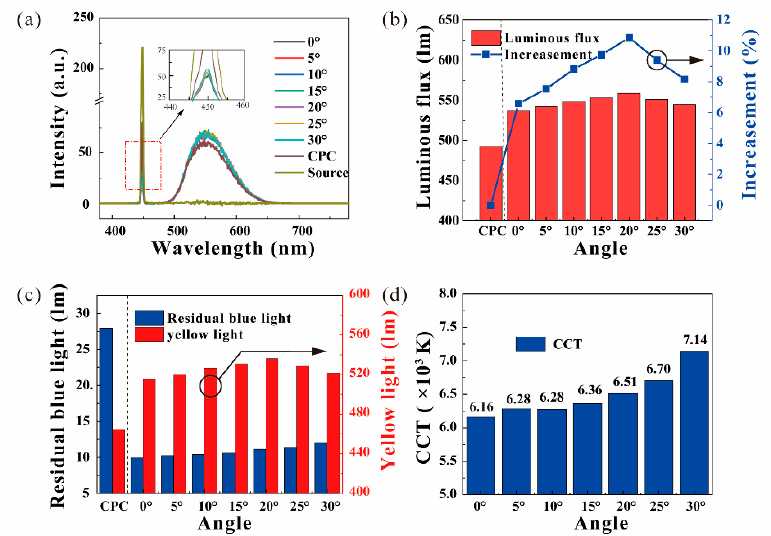
Figure 5. Effects of the title angle of the filter, spectra of ( a ) the CPCs, the ATFPCs; ( b ) luminous flux and increase in the ATFPCs over the CPCs; ( c ) residual bule rays and yellow light; ( d ) the correlated color temperature (CCT) changed with the title angle α .